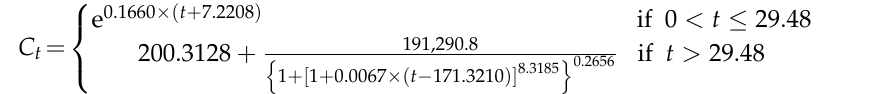
, adjusted-deviance reduction ratio; LRS, Likeli- dev